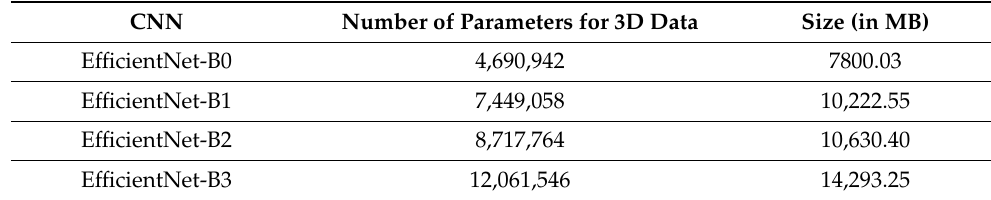
Table 4. Implemented EfficientNet